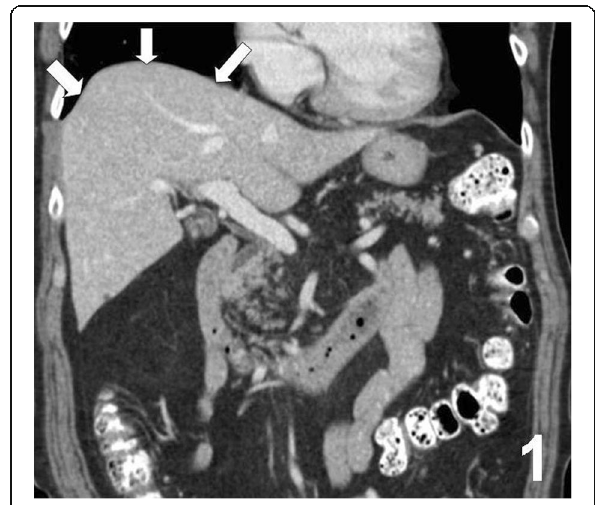
Fig. 1 Anatomy of the hepatic dome. Coronal reformatted computed tomography image demonstrating the anatomical site of the hepatic dome (arrows)